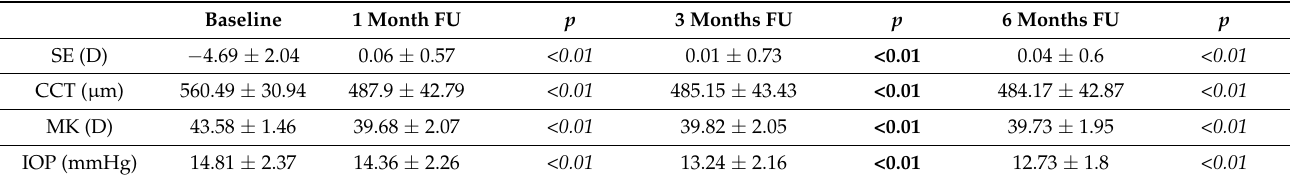
Table 1. The means ± standard deviations of refractive errors (SE), central corneal thickness (CCT), mean keratometry (MK) and intra-ocular pressure (IOP) measured before photorefractive keratectomy (PRK) and at 1, 3 and 6 months of follow-up (FU).